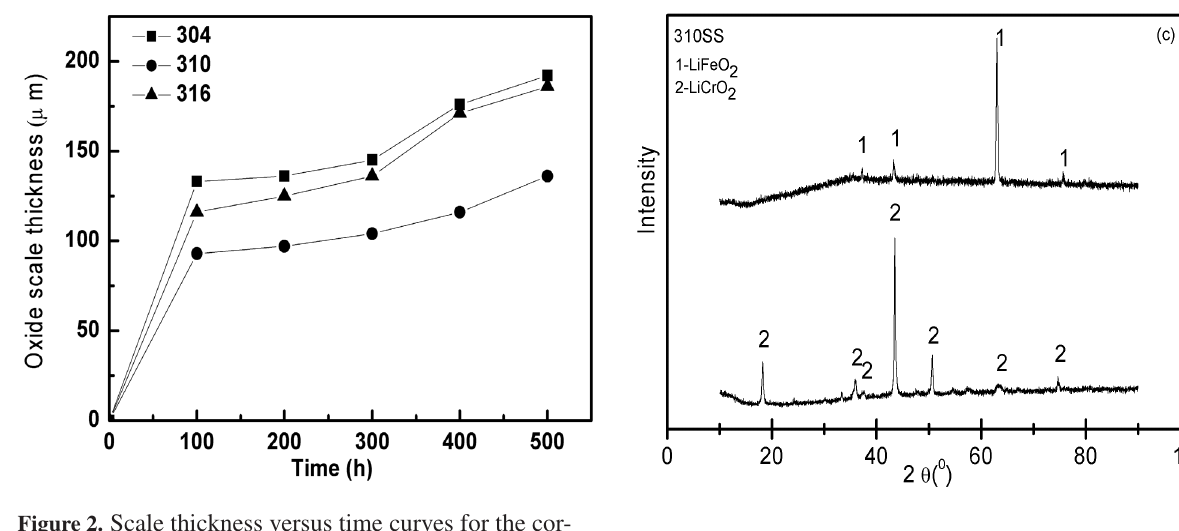
Figure 2. Scale thickness versus time curves for the cor- rosion of type 304, 316 and 310 stainless steels in 90 % eutectic (Li,Na,K) 2 CO 3 mixture-10 % eutectic (Na,K)Cl mixture at 973 K in air.